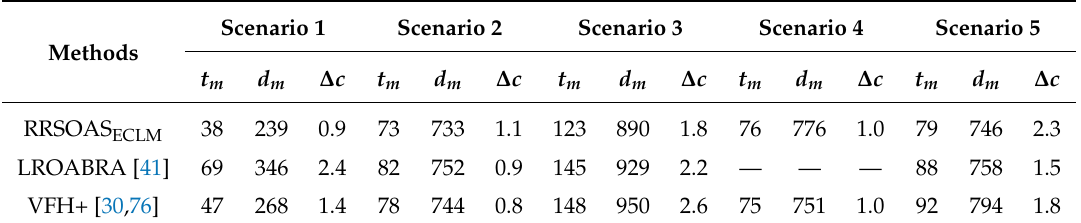
Table 3. Indicators (55) achieved by each obstacle avoidance method in the scenarios proposed in [31]. The results of the VHF+ [30,76] and LROABRA [41] methods have been obtained in